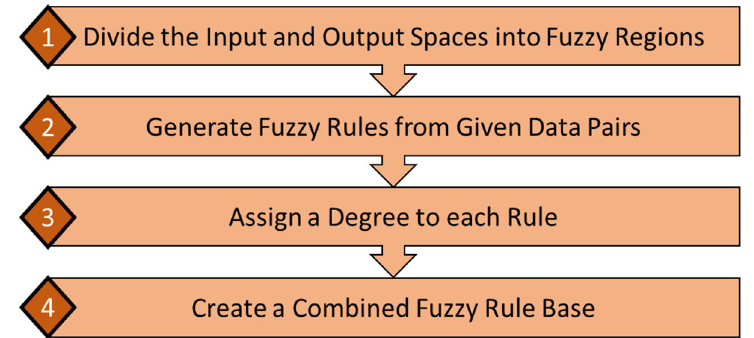
Figure 3. The sequence of fuzzy rules creation in WM method.